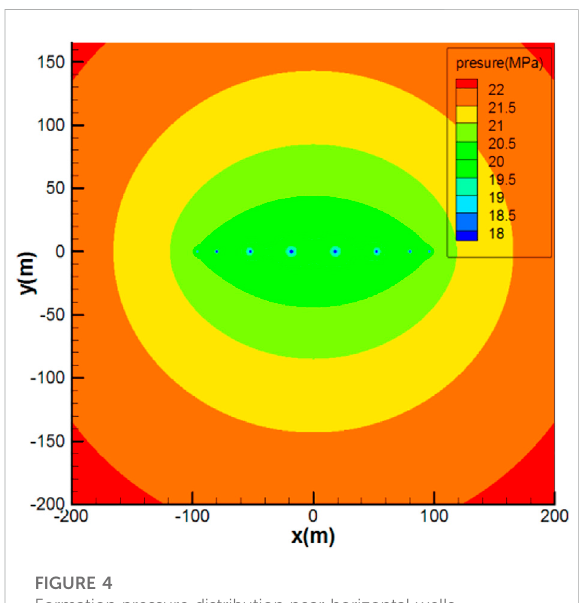
FIGURE 4 Formation pressure distribution near horizontal wells. FIGURE 5